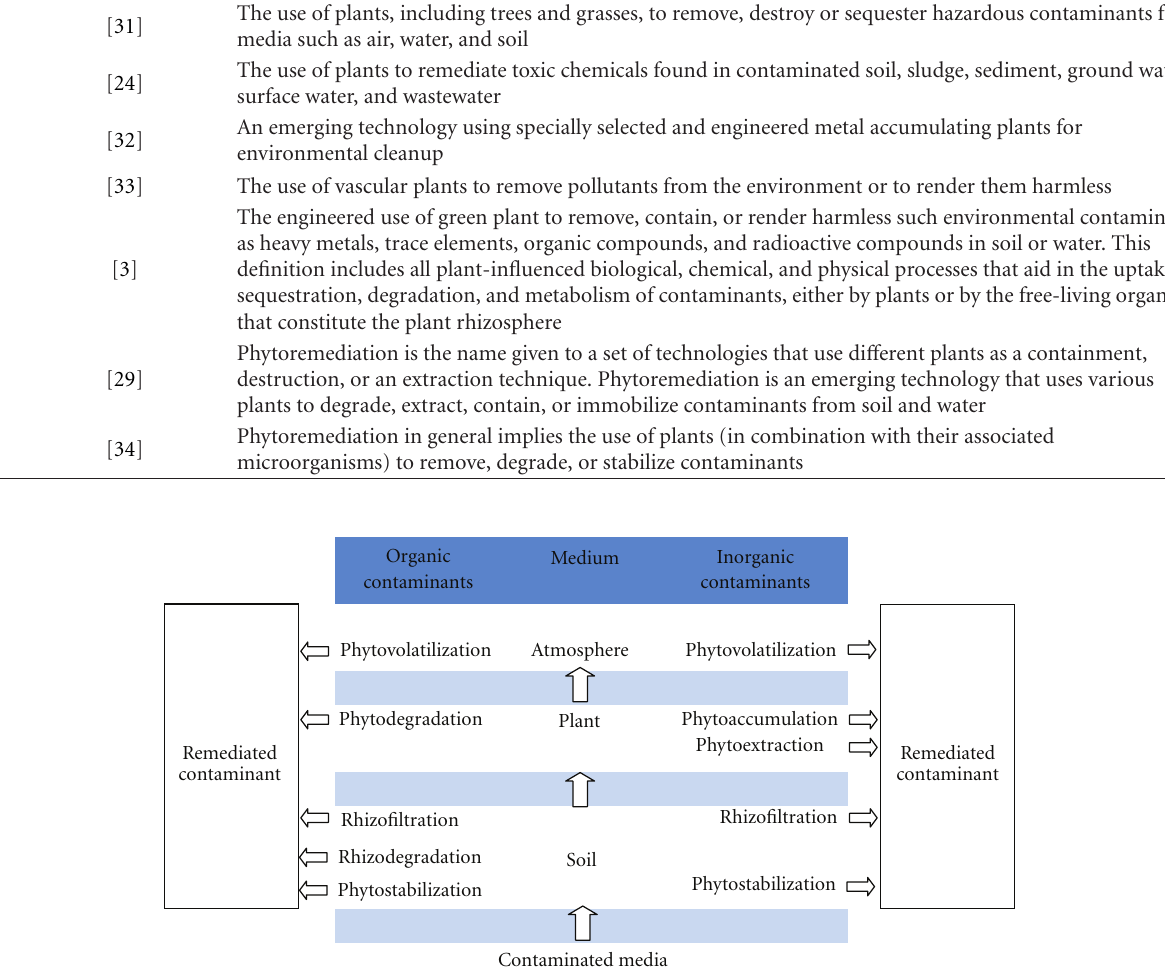
Figure 1: Uptake mechanisms on phytoremediation technology. Source: